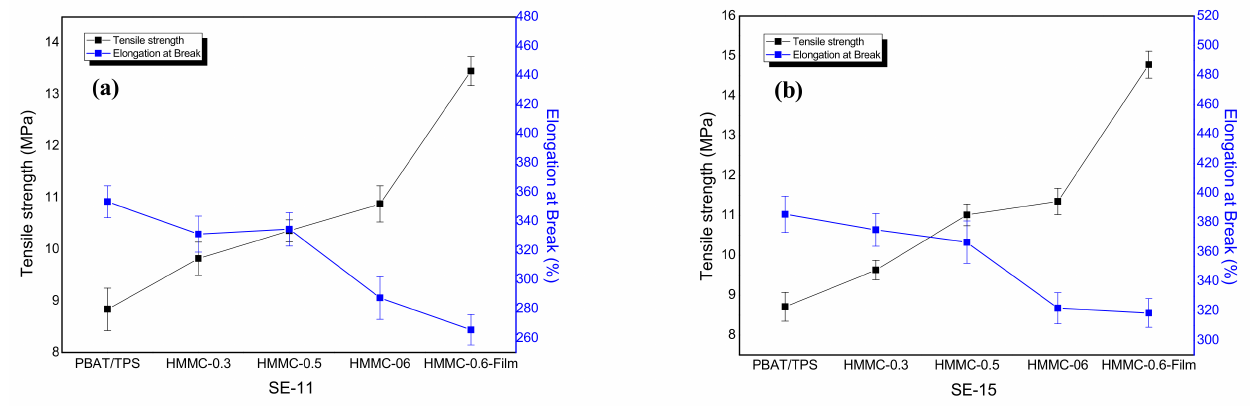
Figure 4. The tensile strength and elongation at break of PBAT-HMNC composites: ( a ) SE-11 and ( b )